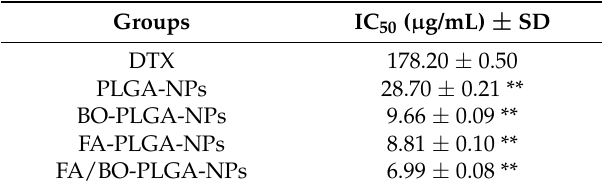
Table 2. IC 50 of the experimental groups on Caco-2 cells.